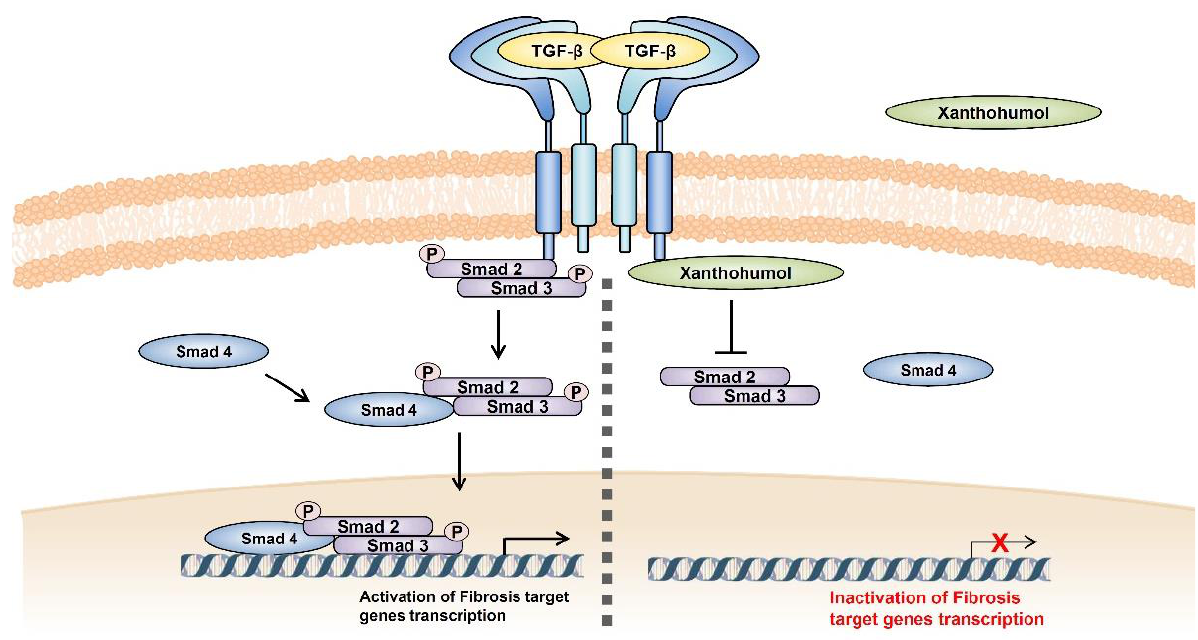
Figure 5. Schematic representation. Treatment of TGF- β 1 aggravated the signaling of TGF- β /Smad and transcription of fibrosis-related target genes. However, exposure of XN mitigated the signaling cascade by interfering with the binding of T β RI and Smad3. “ ↓ ” Indicates induction, “ ┻ ” indi- cates inhibition, and “ ⓟ ” indicates phosphorylation.